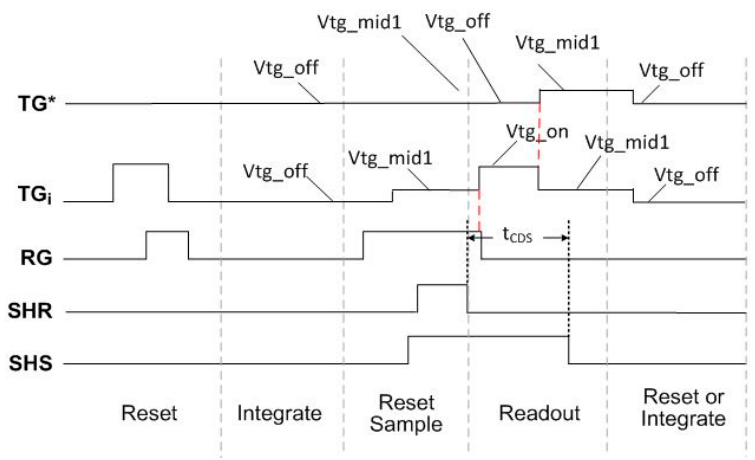
Figure 7. Pixel timing diagram used in this experiment due to limitations with sensor row decoder design.